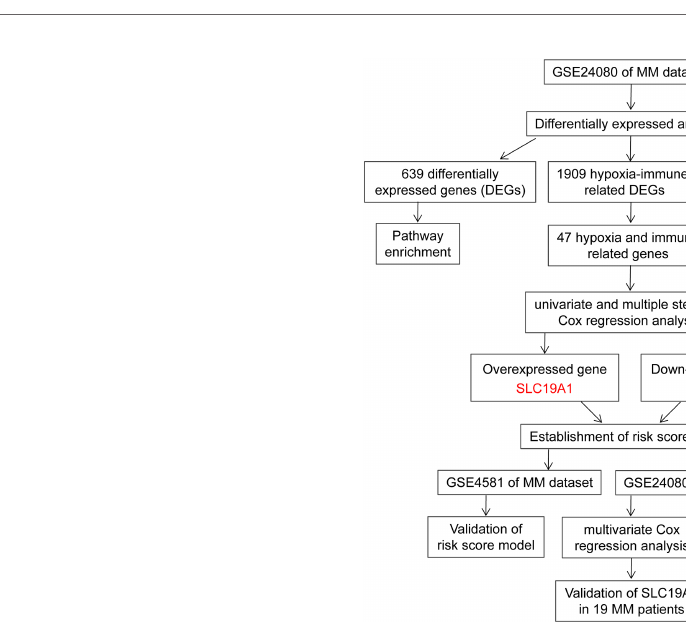
FIGURE 1 | Overall design to screen and validate the hypoxia – immune-related gene SLC19A1 for multiple